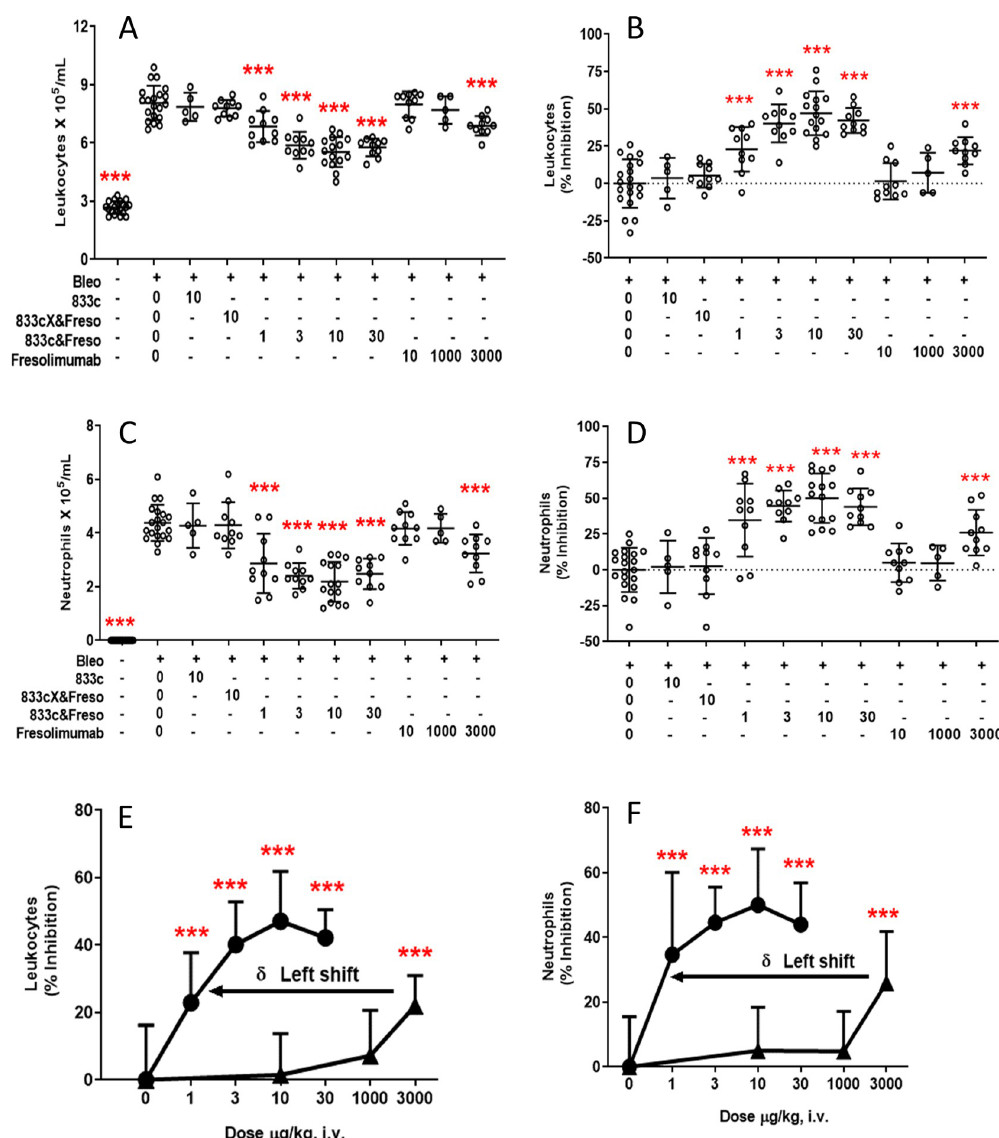
Fig 6. Lung targeting increases therapeutic potency of TGF- β blockade. Two days after bleomycin exposure, rats were treated iv with 833c, 833cX&Freso, 833c&Freso, or fresolimumab at the indicated doses ( μ g/kg). BALf was collected on day 3. Total leukocytes (A) and neutrophils (C) per ml of BALf. Percent (%) inhibition of leukocyte (B,E) and neutrophil (D,F) accumulation in BALf. (E,F) 833c&Freso (solid circles), fresolimumab (solid triangles). Graphs and statistical analysis as in Fig 3. Data were pooled from 1 to 4 independent experiments with n = 5–20 rats per group.